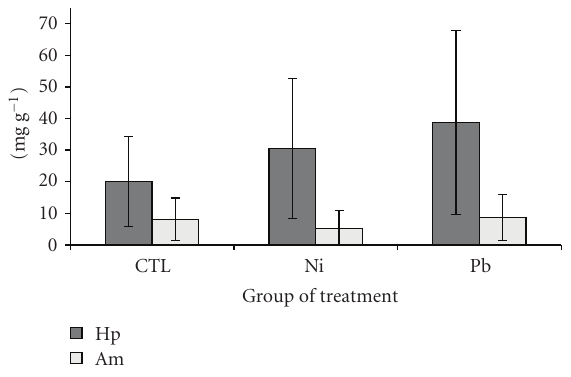
Figure 2: Lipid concentration (mgg − 1 ; mean ± sd) in hepatopan- creas (Hp) and abdominal muscle (Am) of Penaeus vannamei after 10 days of exposure.